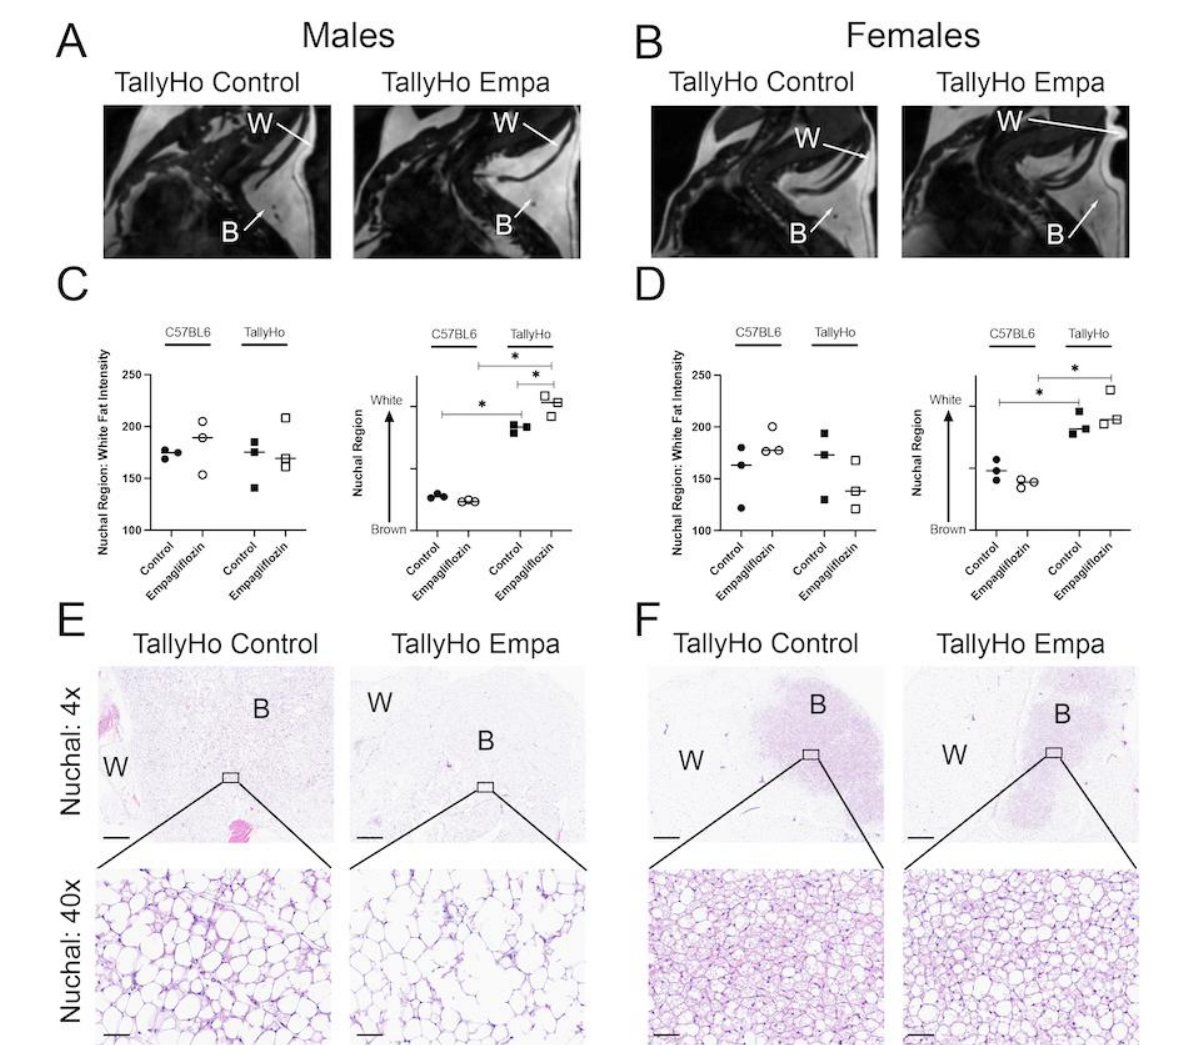
Figure 9. Empagliflozin decreases nuchal brown fat in TallyHo male mice. MRI was performed on the nuchal region of both C57BL6J and TallyHo male ( A ) and female ( B ) mice in the sagittal orientation. Representative images of this region are shown highlighting the brown adipose ROI (labeled ‘B’) and the white adipose ROI (labeled ‘W’). Mean intensity was measured for the white adipose ROI ( C , D ). To quantify the brown adipose ROI, the intensity of the brown region was normalized to the white region. An increase in intensity of the brown ROI is an indication that the nuchal region has increased its white adipose (( C , D ) left graphs). ( E , F ) Representative H&E-stained nuchal regions are shown for the TallyHo mice at both 4x and 40x. The ‘B’ and ‘W’ regions of interest are noted. White adipose was found to be increased in Empagliflozin-treated TallyHo male mice. * p < 0.05 between the labeled groups calculated by 2-way ANOVA followed by multiple comparisons. Scale bar = 60 µ m.